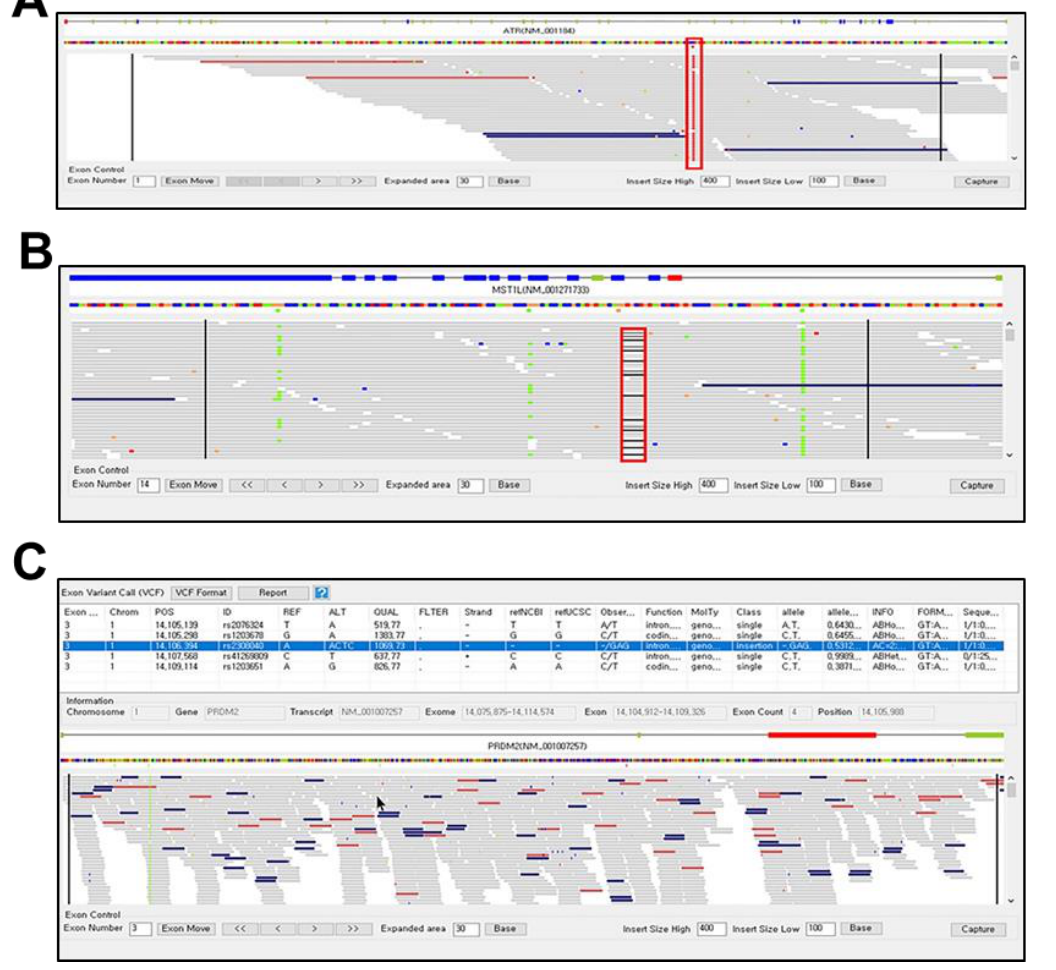
Figure 3. Identification of genetic variants in an exome browser. ( A ) Single nucleotide polymorphism (SNP) in an ATR gene. The red box indicates the position of SNP. ( B ) Deletion in a MST1L gene. The deleted area is shown in a red box. ( C ) Insertion of the sequences in a PRDM2 gene. The position of the insertion is indicated by the arrow.